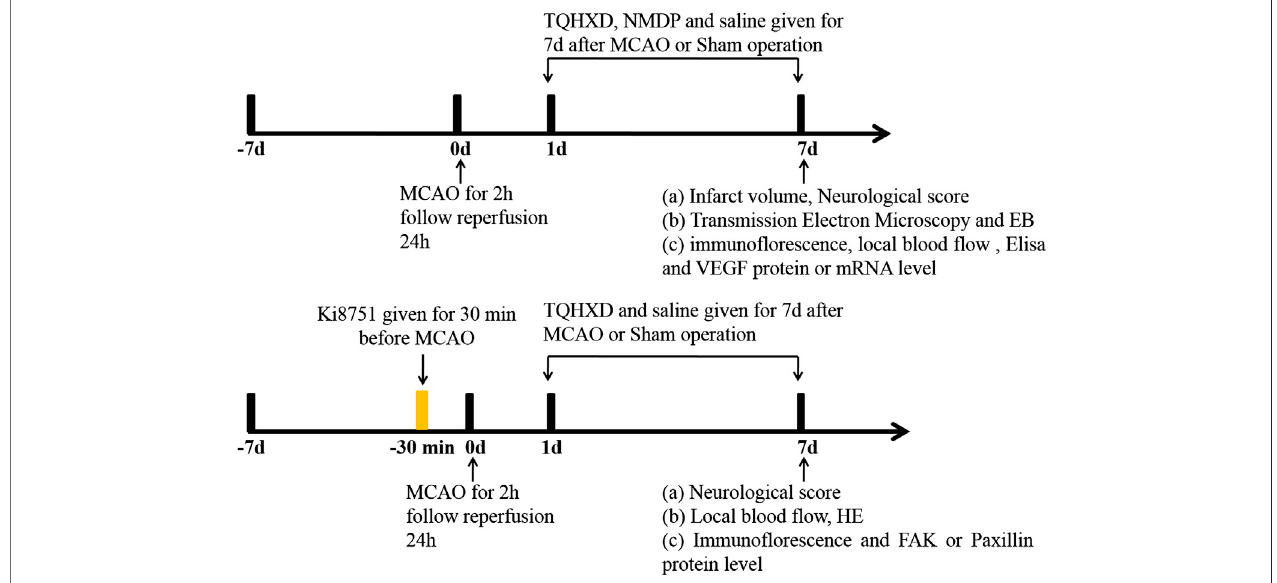
FIGURE1| Experimental design and schedules. MCAO: middle cerebral artery occlusion;TQHXD: Tongqiao Huoxue Decoction; EB: Evansblue; ELISA: enzyme- linked immunosorbent assay; HE: hematoxylin-eosin staining; VEGF: vascular endothelial growth factor; FAK: focal adhesion kinase.